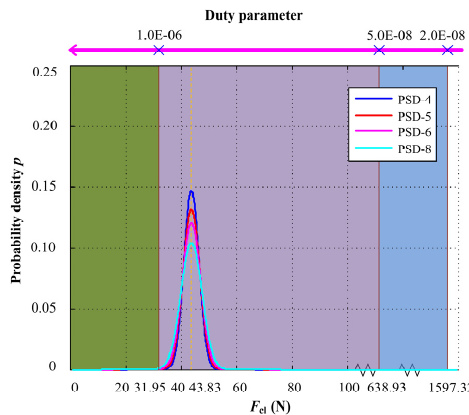
Figure 8. Probability density of closing force F cl under different input acceleration PSDs and the relationship with duty parameter G.